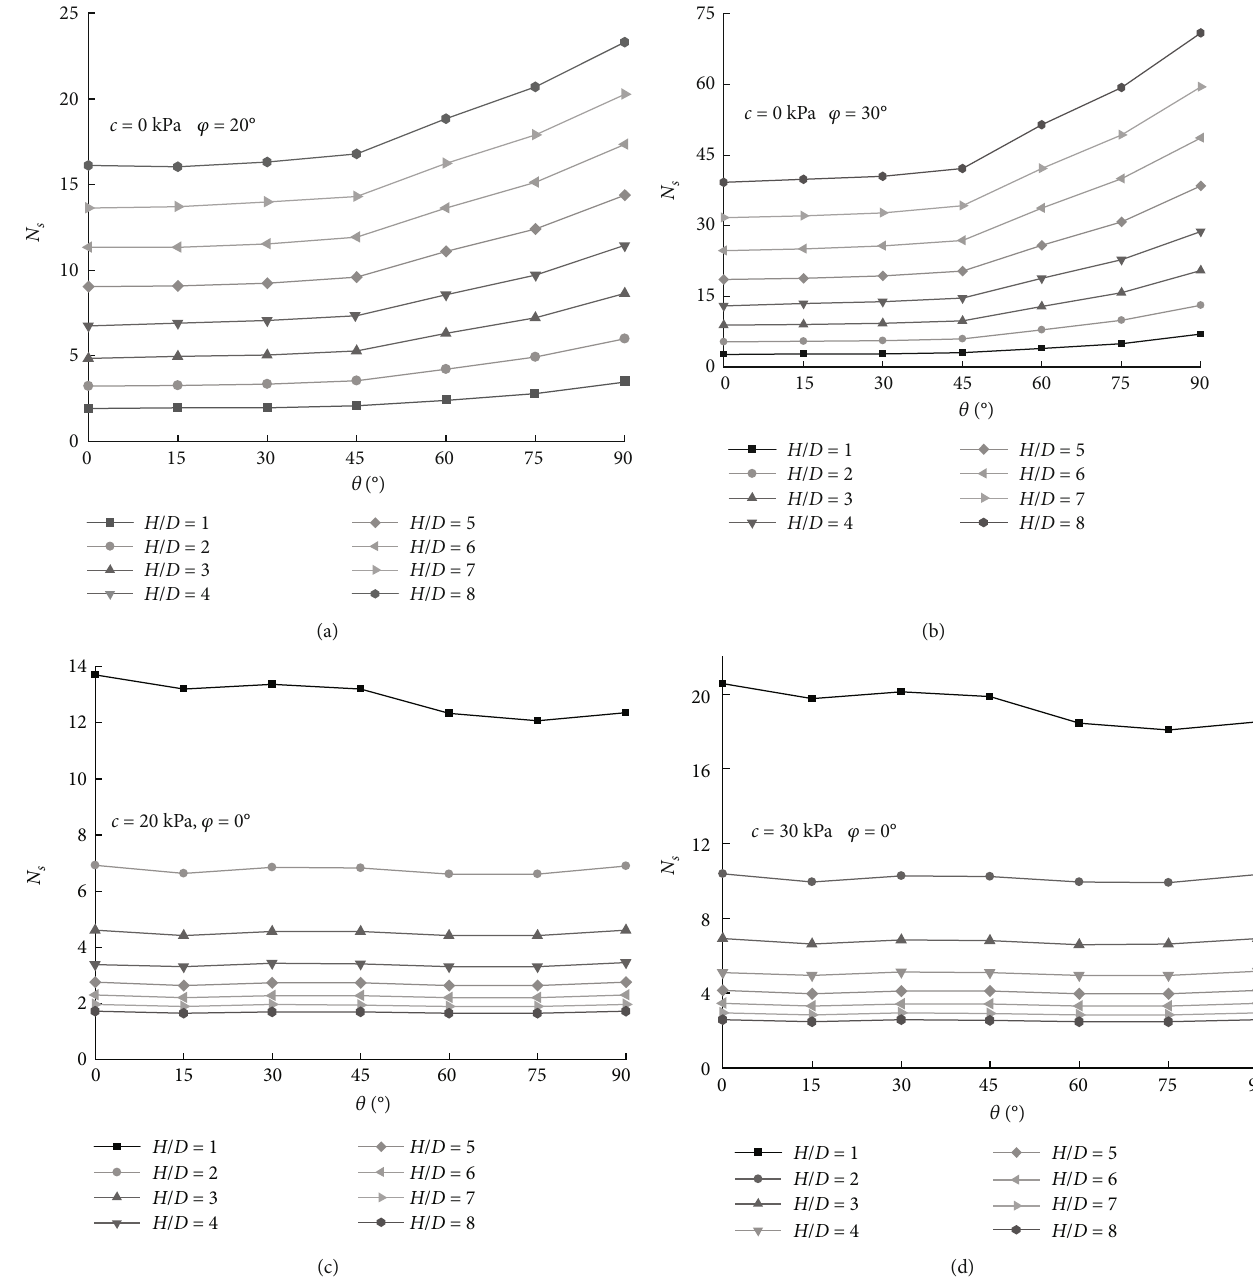
ff erent H / D for c = 0kPa and φ = 0 °